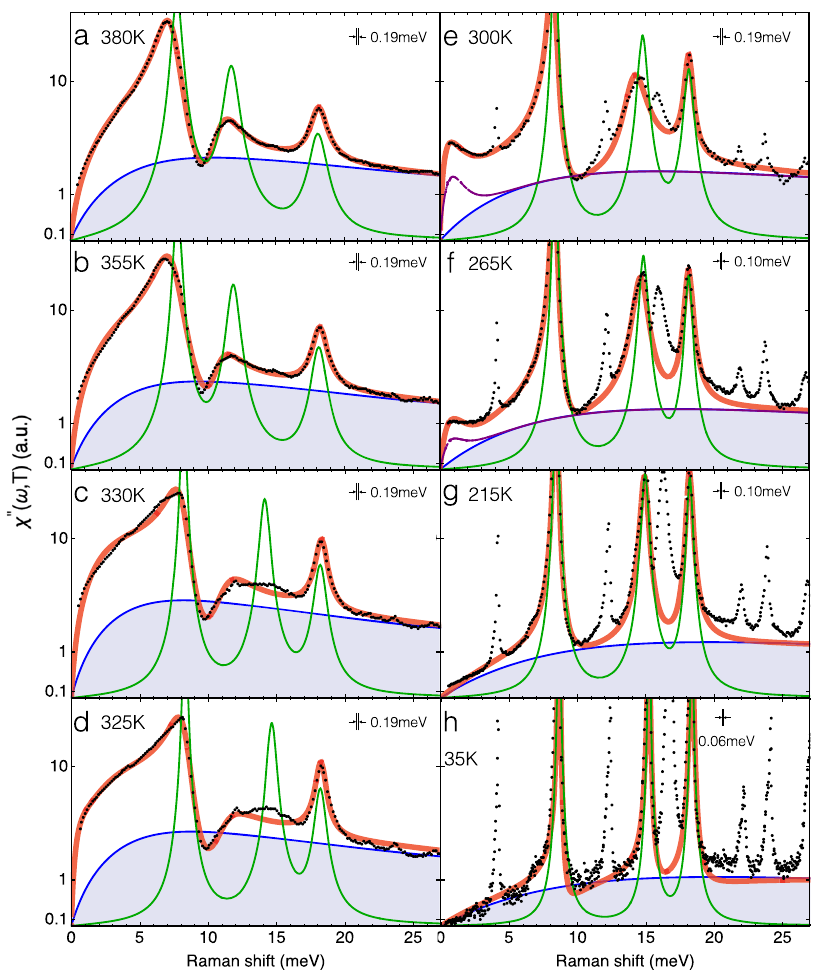
ð ω Þ data (black dots) for Fig. 3 Temperature dependence of the low-energy Raman response in the ac scattering geometry. a – h show χ 00 ac temperatures from 380 K to 35 K on a semilog scale. Thick red lines show the fi ts to the data with a generalized Fano model (see Methods) of ð ω Þ , Eq. (1). The deduced bare phonon and continuum responses are three phonons coupled to a continuum with a relaxational response χ 00 cont shown by green line and blue line with shading, respectively. Full Fano model response (red) does not equal sum of the two due to the presence of interference terms (see Supplementary Note 1.3). e , f Below T c , an additional enhancement at low frequencies is modeled by a low-energy mode, originating from recoil scattering of acoustic phonons on the structural domains (see Methods), interacting with the ð ω Þ is suppressed due to gap continuum. Purple line shows its combined response with the continuum. g , h At lower temperatures χ 00 cont opening, reducing the asymmetry of the phonon modes. Spectral resolution is shown in top right corner of the